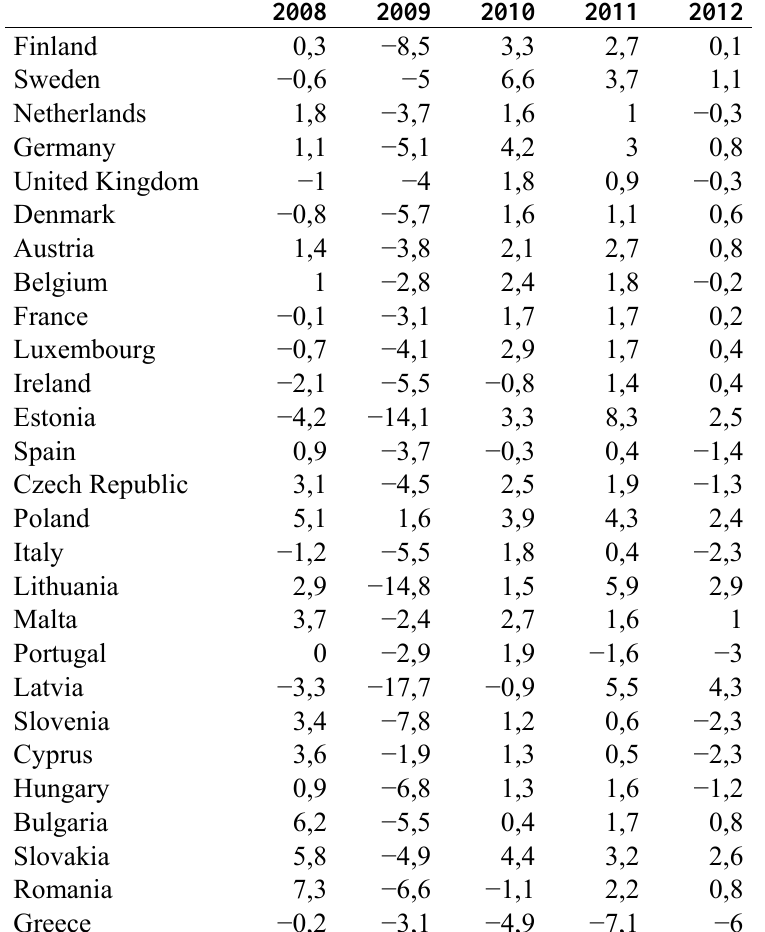
Table 1. Real GDP growth rate, percentage change on previous year *.